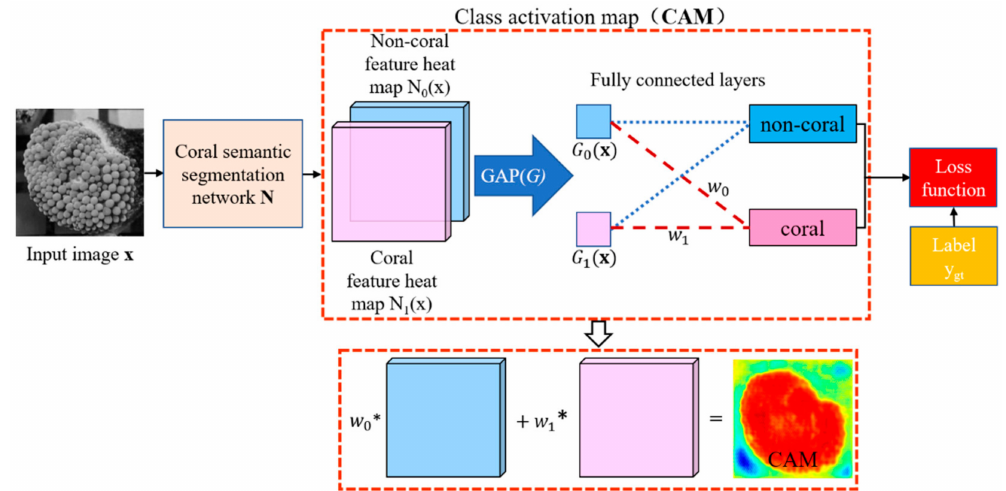
Figure 9. The class activation map (CAM) module in the semantic segmentation